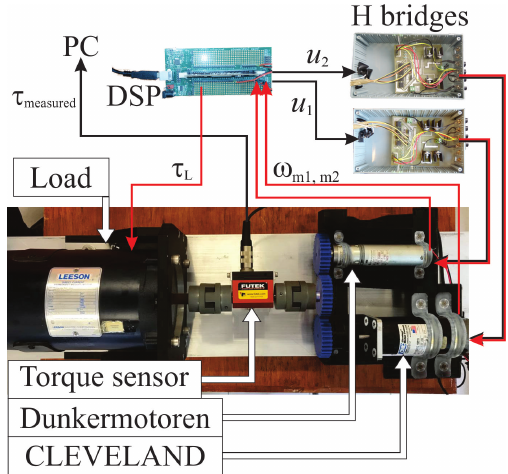
Figure 5. Experimental setup scheme.